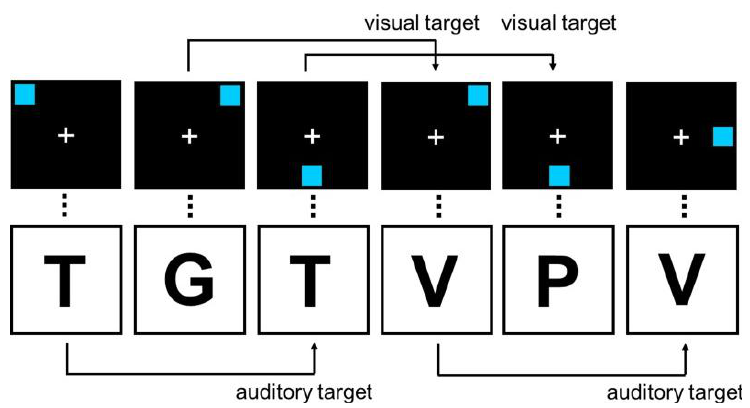
Figure 1. An example of a 2-back condition of a dual n-back task. Reproduced with permission from